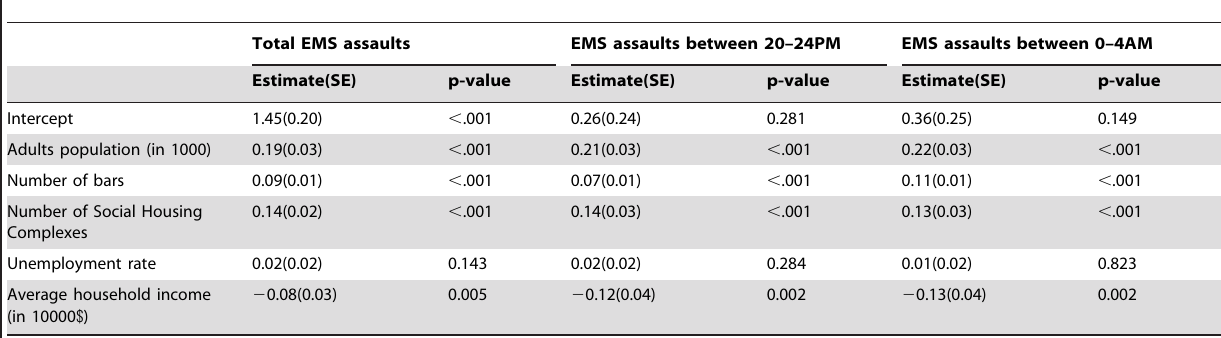
Table 2. Poisson Regression Estimates of Number of EMS